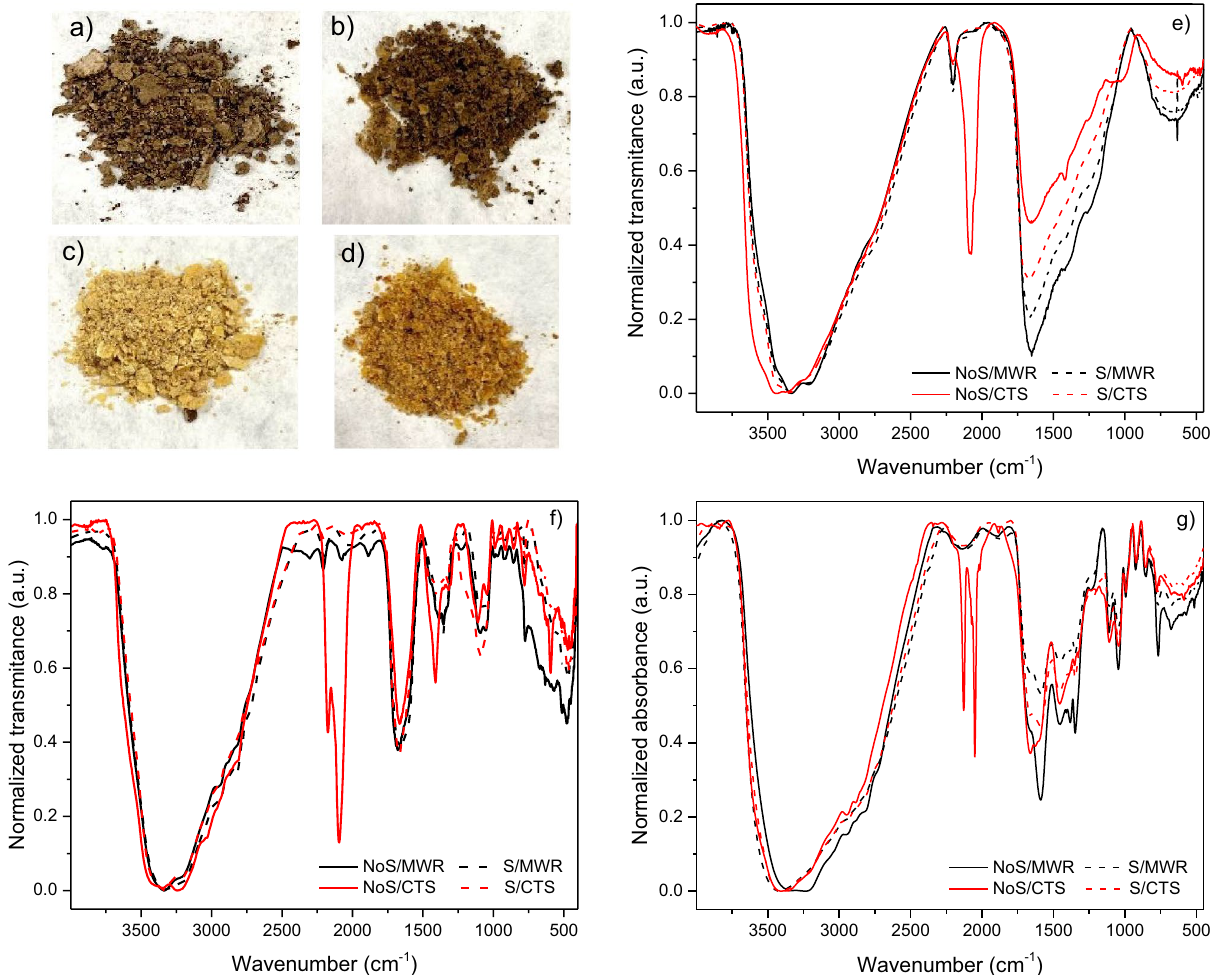
Figure 7. Images of the sol fractions: ( a ) from a static experiment under simulated subaerial conditions (MWR, 180 °C, NoS); ( b ) from a stirring experiment under simulated subaerial conditions (MWR, 180 °C, S); ( c ) from a static experiment under simulated aerial conditions (CTS, 80 °C, NoS); and ( d ) from a stirring experiment under simulated aerial conditions (CTS, 80 °C, S). Representative FT-IR spectra from ( e ) gel fractions; ( f ) heavy fractions (F > 3 kDa) and ( g ) light sol fractions (F < 3